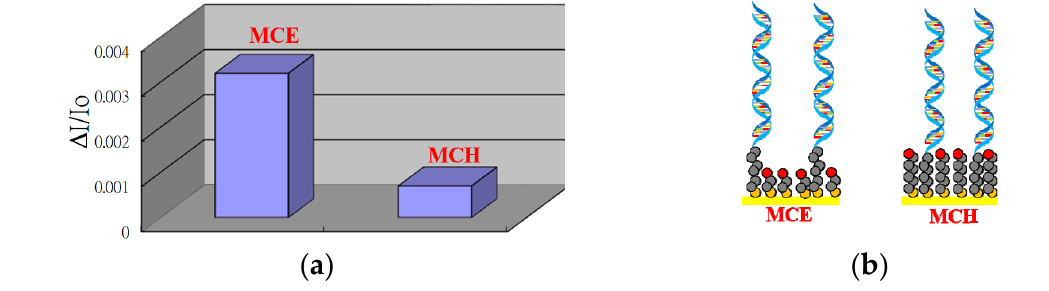
Figure 3. ( a ) Normalized absorbance changes before and after DNA hybridization for 27-mer ssDNA probe-conjugated AuNPs on glass slides based on 2-mercaptoethanol (MCE) or 6-mercaptohexanol (MCH) in the mixed SAM, ( b ) schematic illustration of mix SAMs with MCE and MCH as diluent.